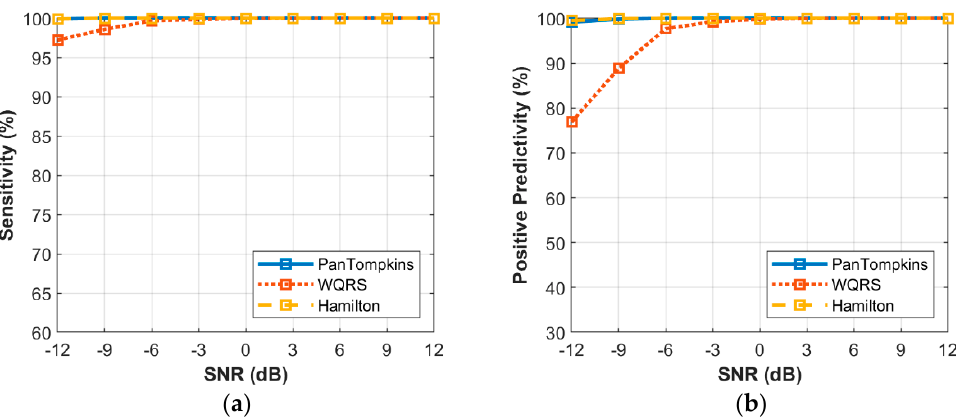
Figure 6. Relationship between the performance of beat detection and BW for the record 100: ( a ) sensitivity with SNR; ( b ) positive predictivity with SNR.